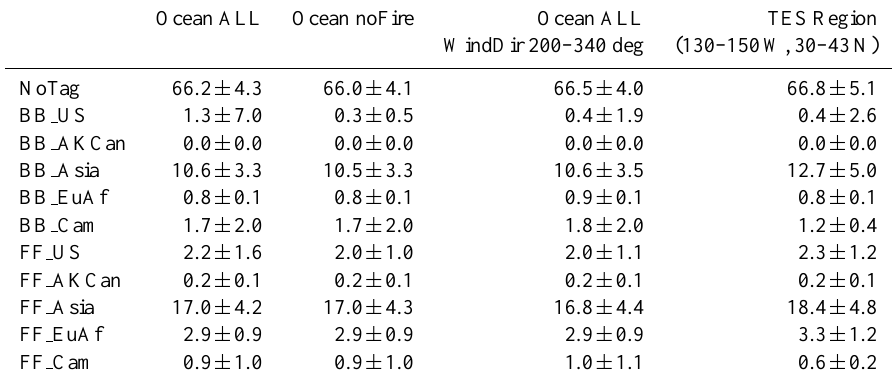
Table 1. Average CO Source Contributions for different CO tracers for AVG RegionTime Ocean data selections (entire data set; entire data set but with fire influenced data omitted; entire data set but selected for wind directions towards the continent) and the TES region for the 2–8km altitude range. The latter is discussed in Sect. 3.3.1. Units areppbV